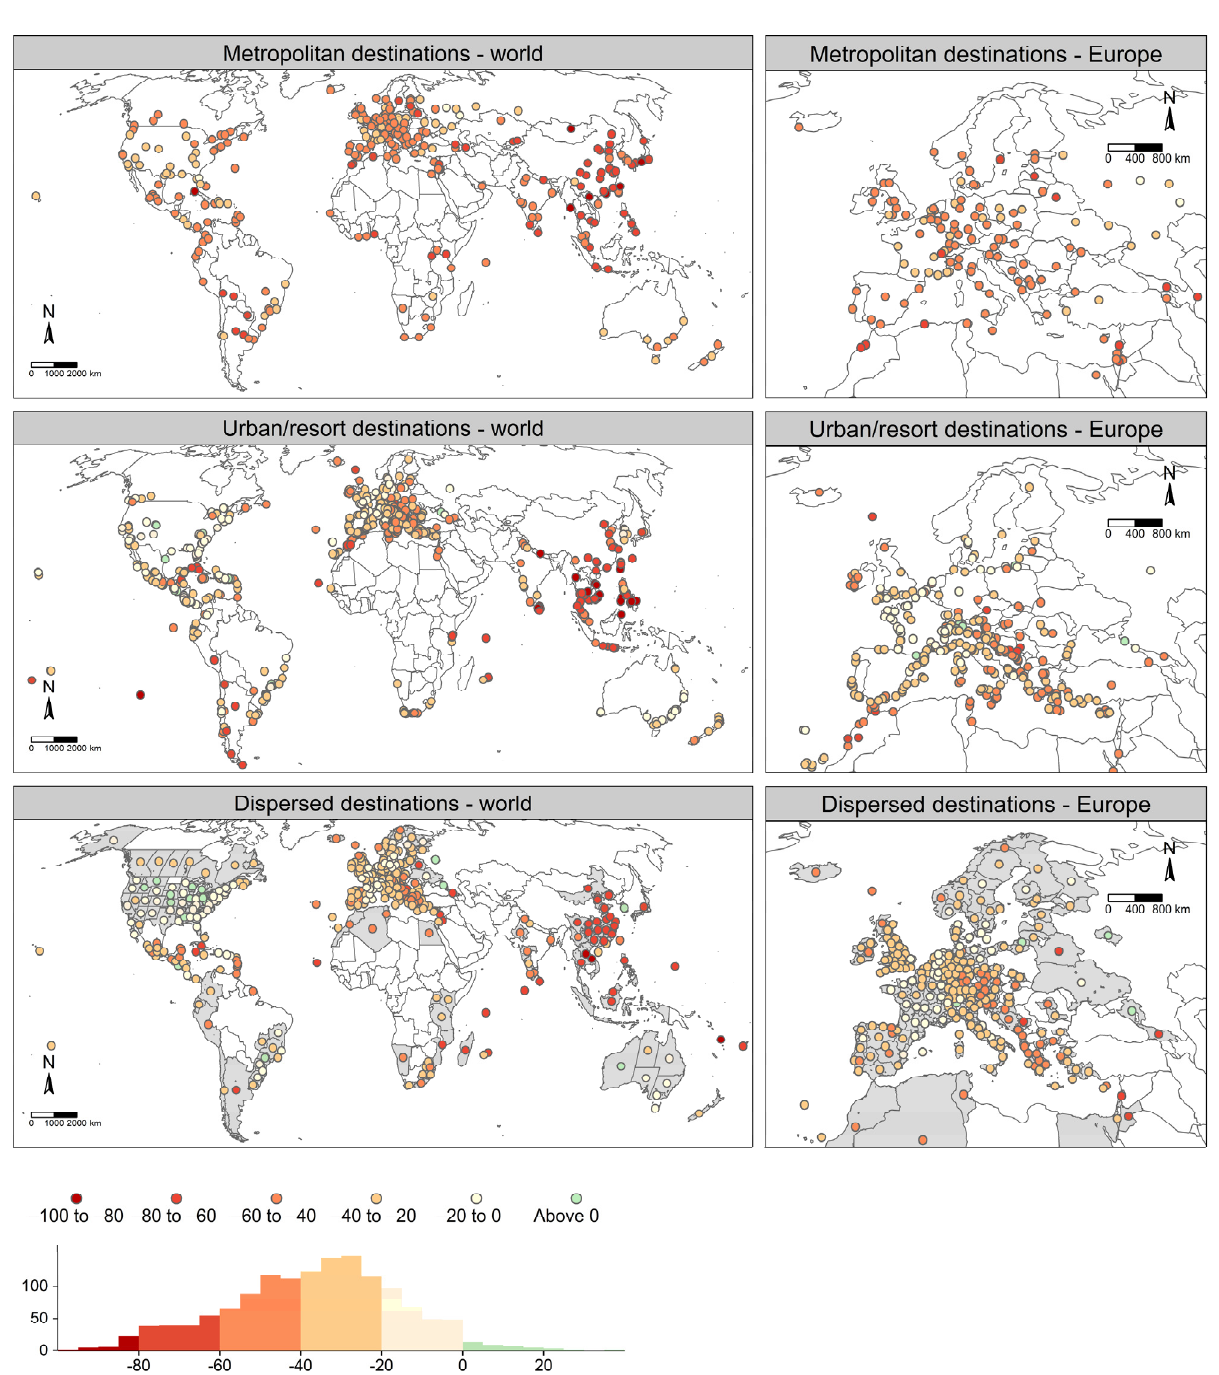
Figure 3. Change in the number of reviews in destinations between 2019 and the mean of